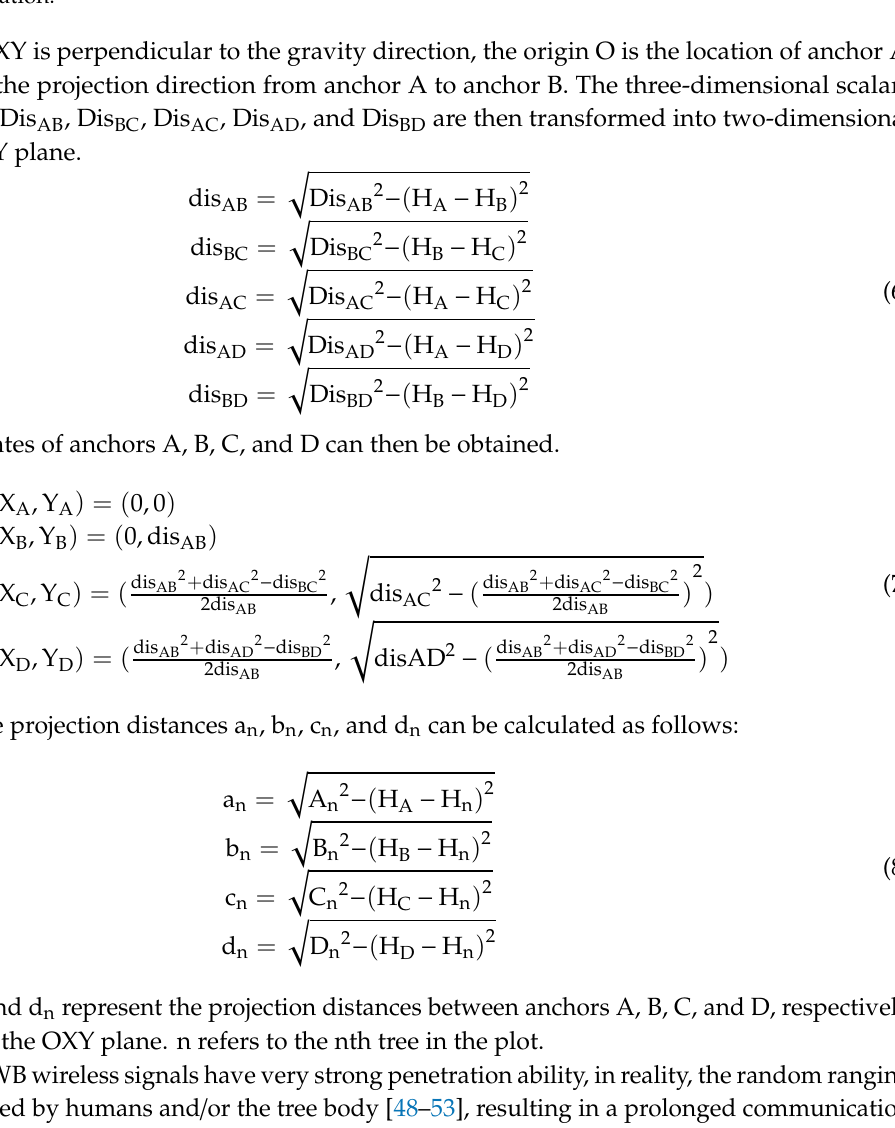
Figure 9. Conversion from a three-dimensional coordinate to a two-dimensional coordinate in tree position estimation.